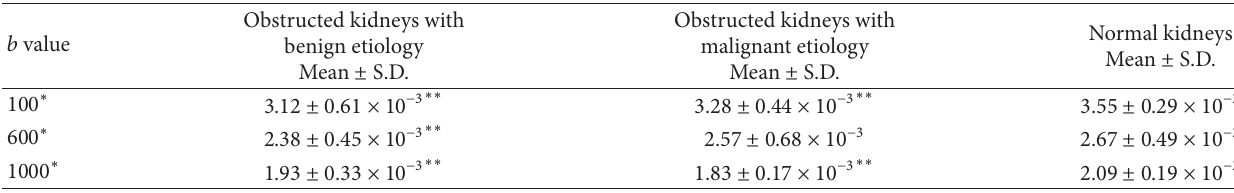
Table 1: Comparison of ADC values of obstructed kidneys with normal kidneys.